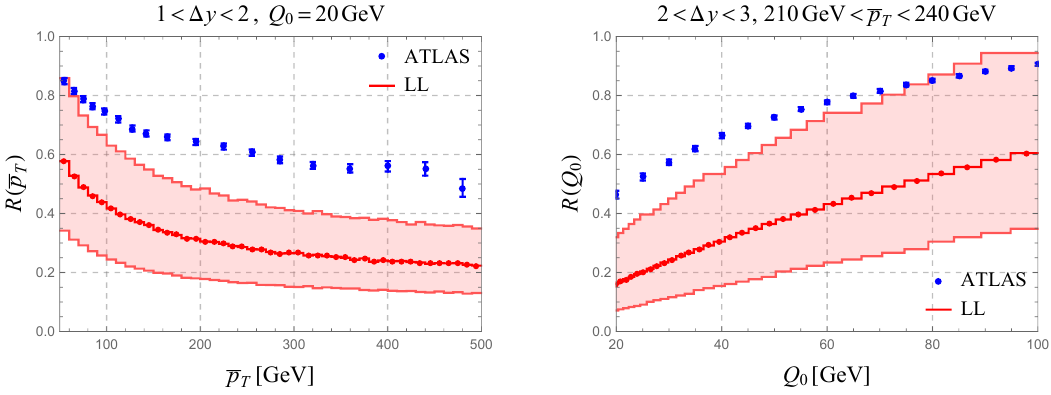
Figure 5 . The gap fraction as a function of the jet transverse momentum p gap energy Q 0 (right plot). The red line shows the LL result for the gap fraction; the error band is obtained from scale variation. The ATLAS data is plotted in